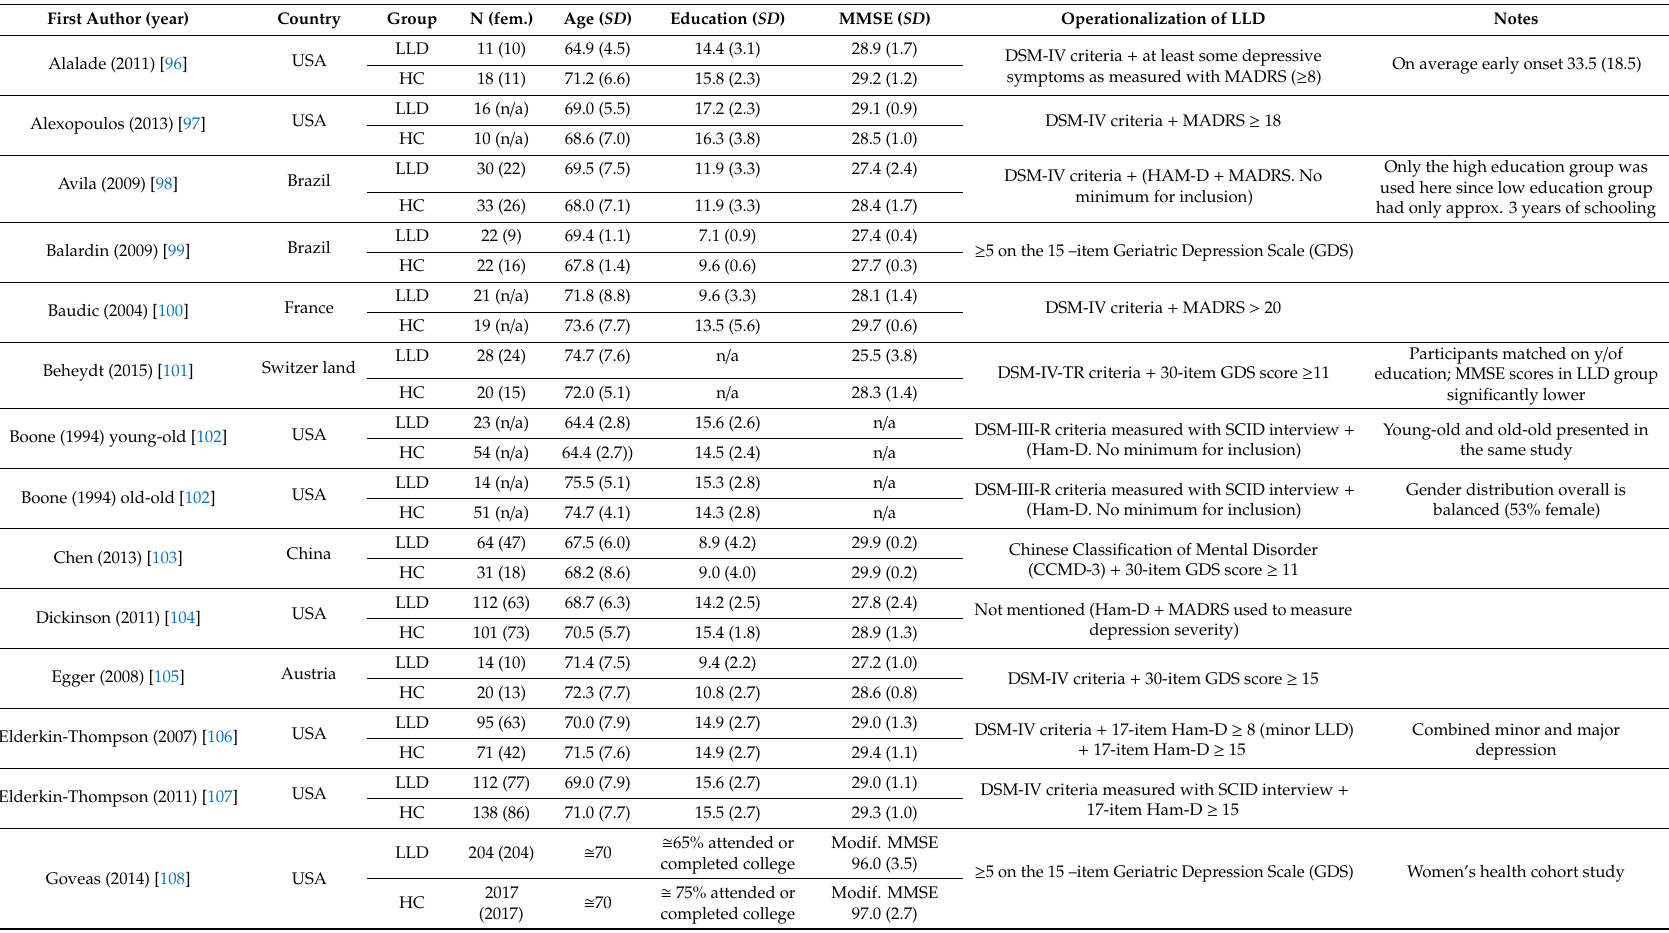
Table 2. Study characteristics of individual studies on cognitive function in late-life depression. Demographic information includes where the study took place, participants’ age and gender, educational background, and performance on the mini-mental state examination. Additionally, information is provided on how each study operationalized depression (continued on the next